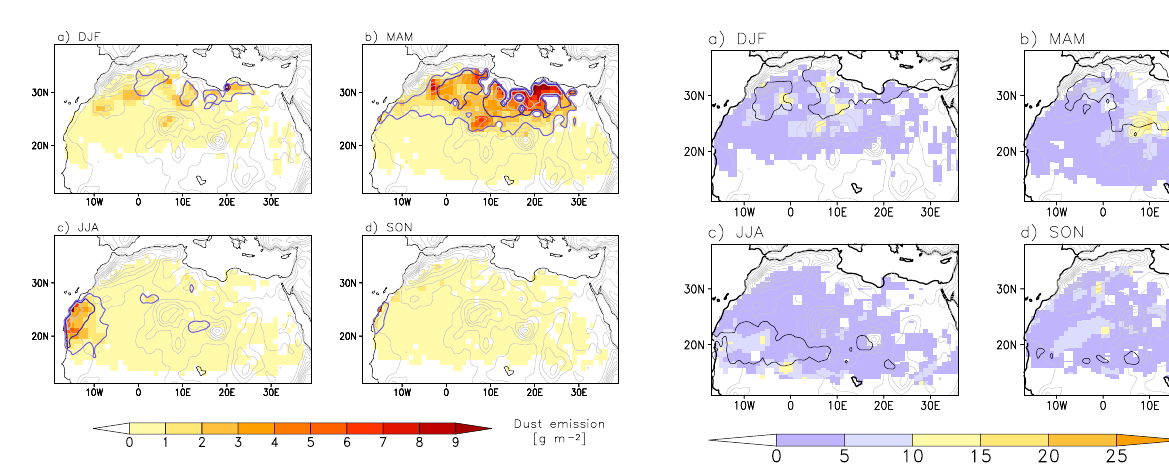
Figure 13. Seasonal fraction of dust emission amount associ- ated with long-lived and migrating cyclones. Shown are fractions of total dust emission associated with depressions in percent for (a) December–February, (b) March–May, (c) June–August and (d) September–November averaged for 1989–2008 (shaded). Dust emission within a radius of 10 ◦ from the cyclone centre is consid- ered (Sect. 2). Areas within the black contour have an occurrence frequency of depression of more than 0.2% (Fig. 2). Grey contours show the orography in steps of